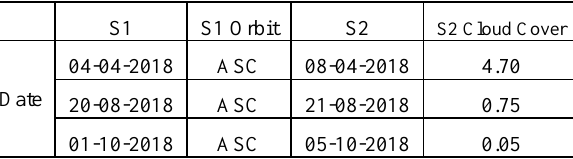
Table 2. Overview of the radar (S1) and optical (S2) satellite imagery used in this research.